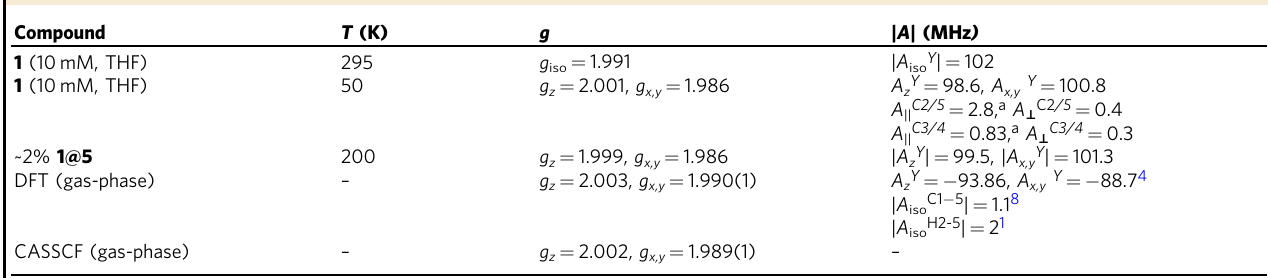
a For the parallel and perpendicular 13 C hyper fi nes, the labels refer to the local principal axes, with the unique axis de fi ned by the Cp ′ π -system, i.e., orthogonal to the molecular z